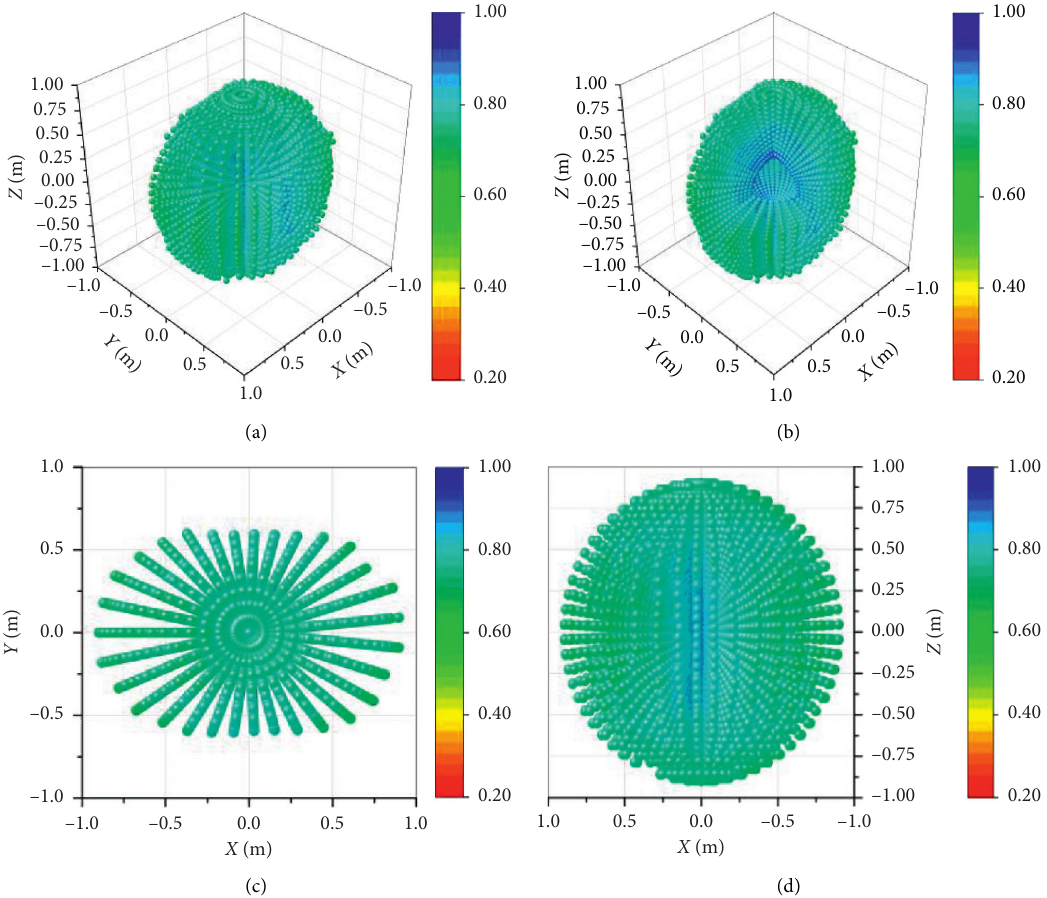
Figure 6: TOSM of the system in the workspace under the static condition. (a) Axonometric view. (b) Section view. (c) X - Y plane. (d) X - Z plane.